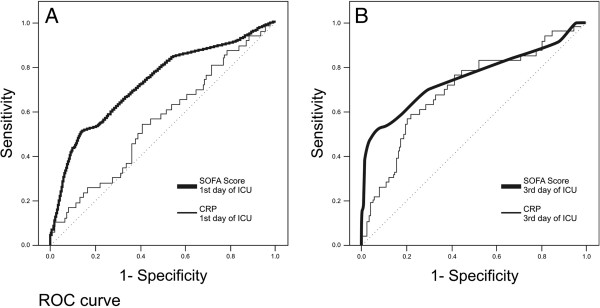
On the left side, the ROC curve for mortality of the first day of ICU, CRP and SOFA scores were shown. On the right side, the ROC curves for mortality on the third day, CRP and SOFA scores were drawn.